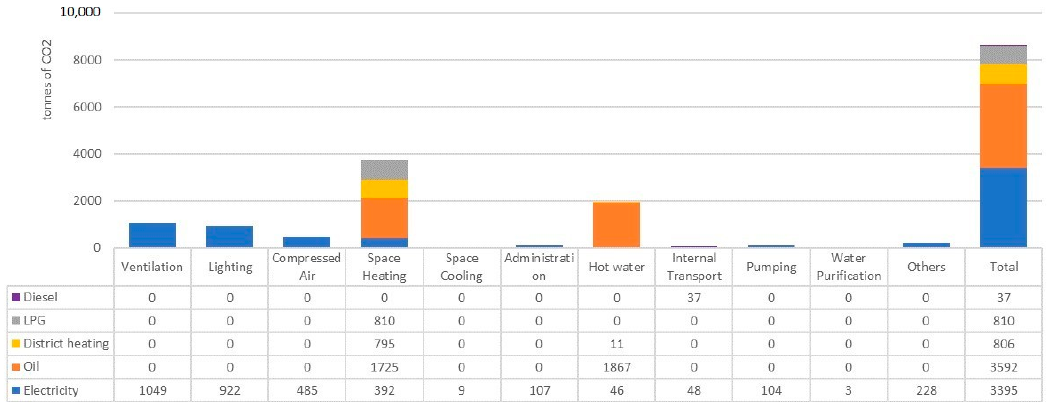
Figure A5. CO 2 emissions for the unit processes in the support category based on the case study of the engineering industry (Scenario 1).